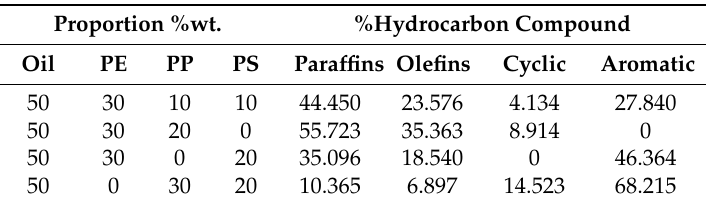
Table 7. Hydrocarbon compounds in the product oils.